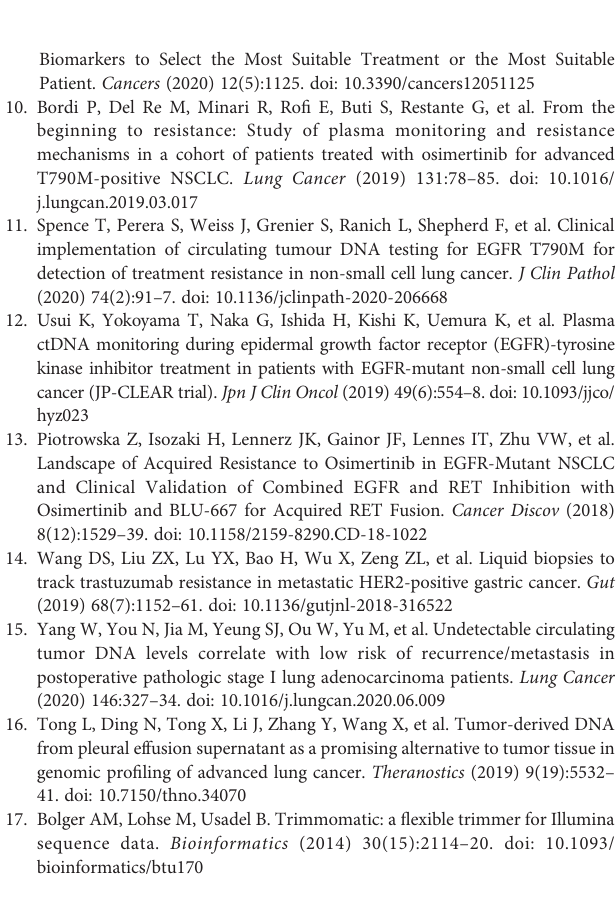
Supplementary Figure 1 | Analysis of progression-free survival of the third- generation EGFR TKIs treatment among those with undetectable cfDNA level and those with detectable cfDNA within post-treatment of 1, 2, 3, or more than 3 months. (A) PFS strati fi ed by different cfDNA level within 1 month after treatment. (B) PFS strati fi ed by different cfDNA level within 2 months after treatment. (C) PFS strati fi ed by different cfDNA level within 3 months after treatment. (D) PFS strati fi ed by different cfDNA level more than 3 months after treatment. Supplementary Figure 2 | Correlation of cfDNA clearance duration with progression-free survival in patients treated with the third-generation EGFR TKIs. Supplementary Figure 3 | Analysis of progression-free survival of the third- generation EGFR TKIs treatment among those with undetectable T790M level and those with detectable T790M within post-treatment of 1, 2, 3, or more than 3 months. (A) PFS strati fi ed by different T790M level within 1 month after treatment. (B) PFS strati fi ed by different T790M level within 2 months after treatment. (C) PFS strati fi ed by different T790M level within 3 months after treatment. (D) PFS strati fi ed by different T790M level more than 3 months after treatment. Supplementary Figure 4 | Correlation of EGFR T790M clearance duration with progression-free survival in patients treated with the third-generation EGFR TKIs. Supplementary Figure 5 | Association of dynamic cfDNA level with imaging